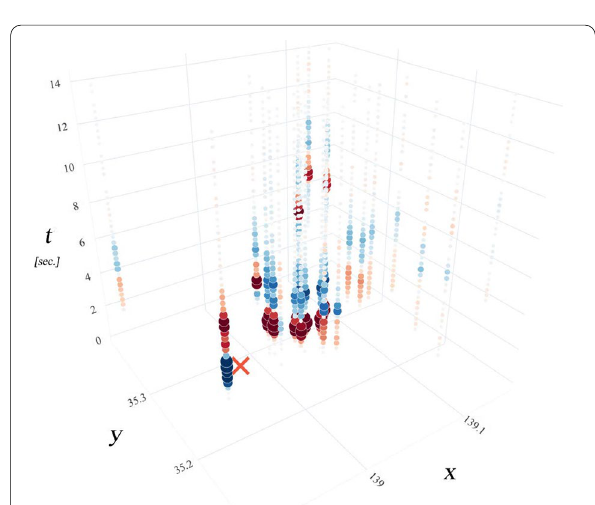
Fig. 3 Map of example propagation image used for learning